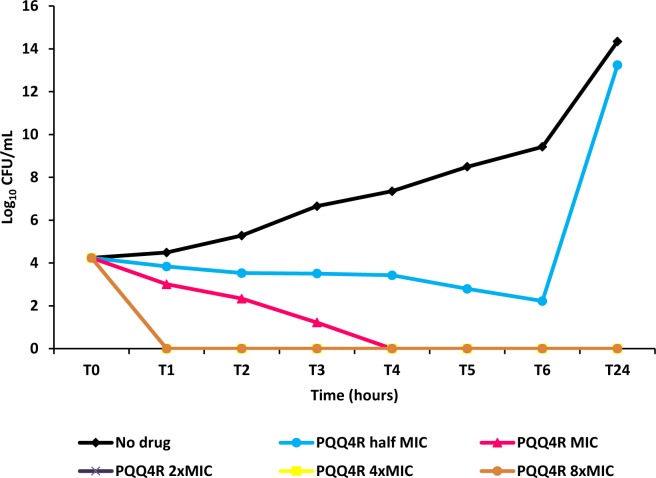
Effect for PQQ4R on survival of E. coli. AG100.The compound was added at concentrations from 0.5× MIC (320  μM) to 8× MIC (5,120 μM) to exponential growing E. coli and survival monitored during 24 h.